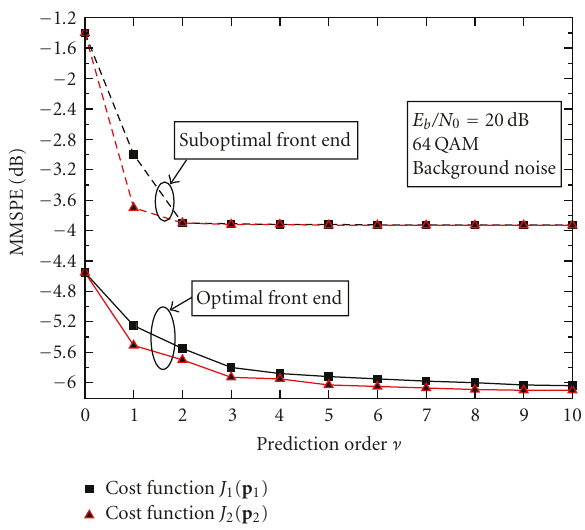
Figure 6: MMSPEs, normalized to the power of the signal s i ( c i as a function of the prediction order ν , assuming a 64 QAM con- stellation, signaling frequency f s = 2 . 4 MHz, and carrier frequency f c = 6